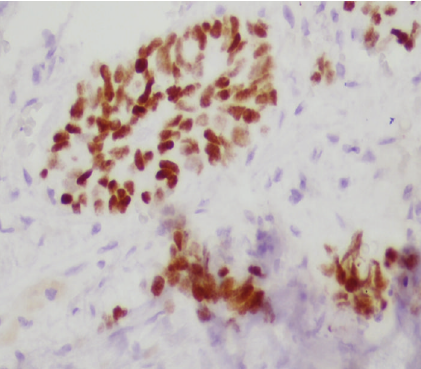
Figure 4: TTF 1 positive staining of the neoplastic cells confirming the cells are of pulmonary origin.